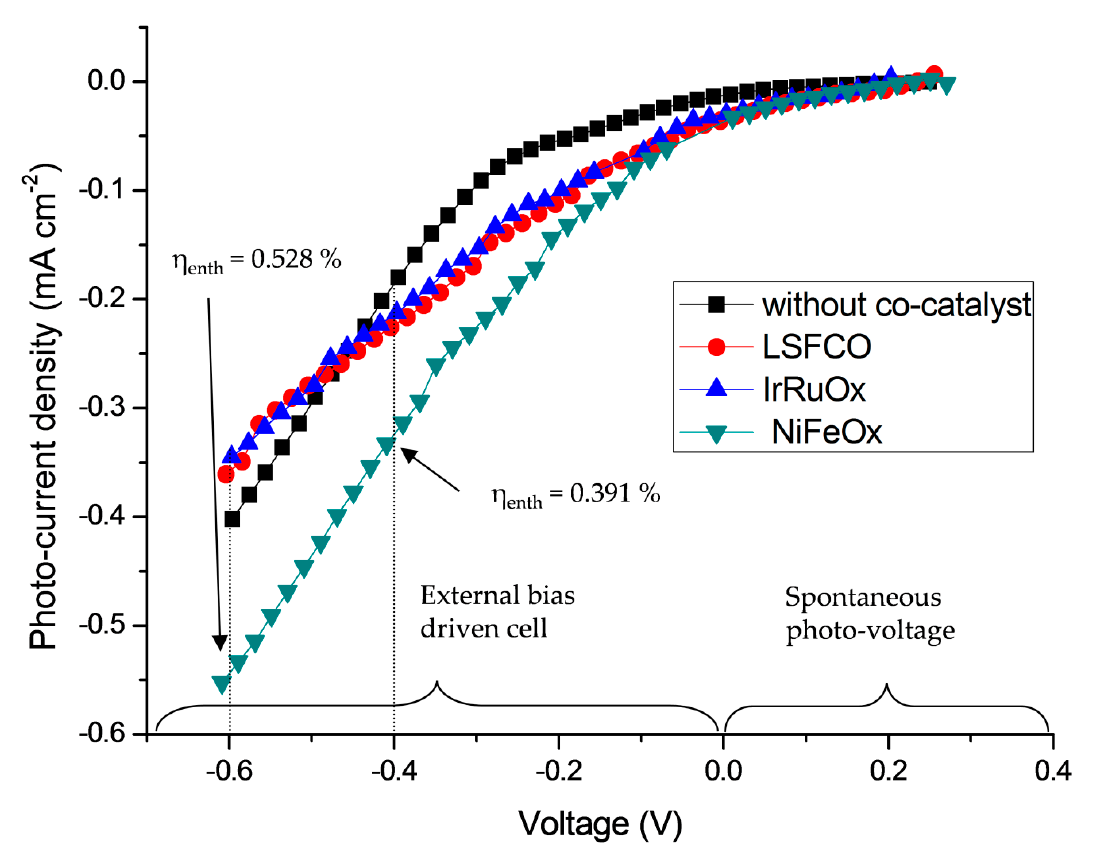
Figure 3. Polarization of the photocurrent for 4 PECs, without any co-catalyst addition and with the IrRuOx, LSFCO and NiFeOx co-catalyst-based photoanodes.